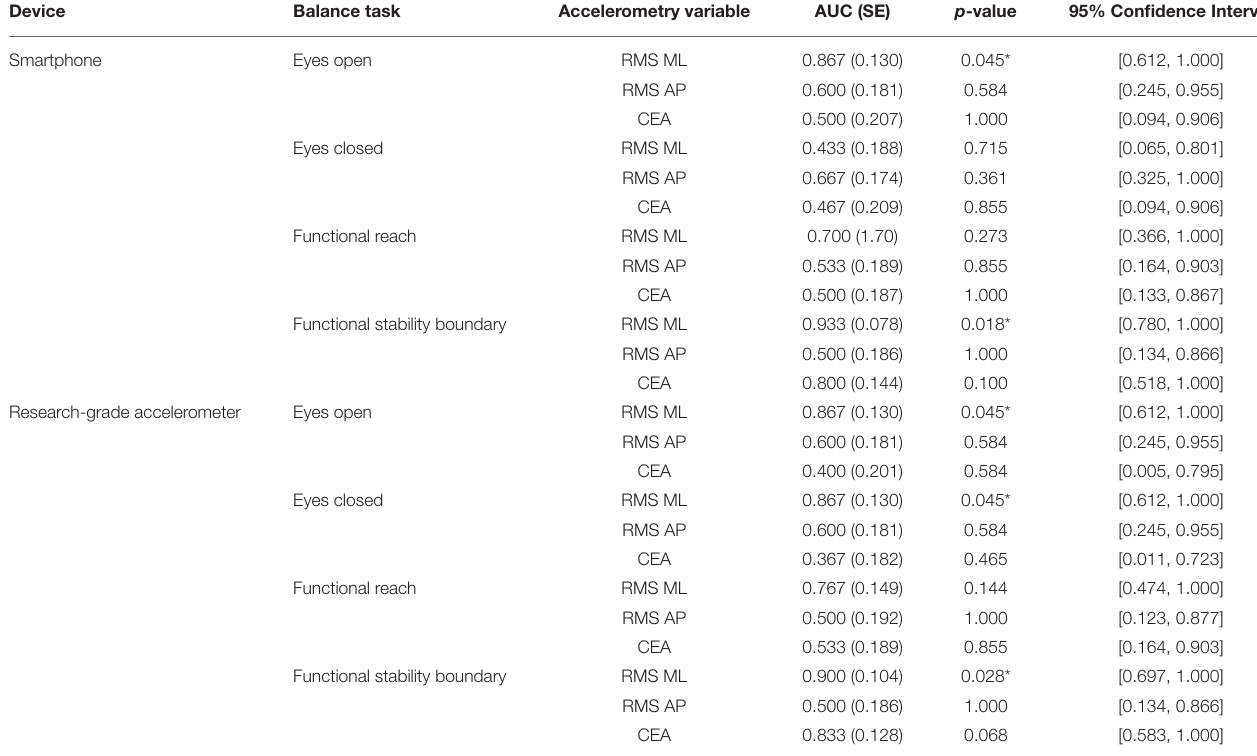
TABLE 6 | Receiver operating characteristic curve statistical